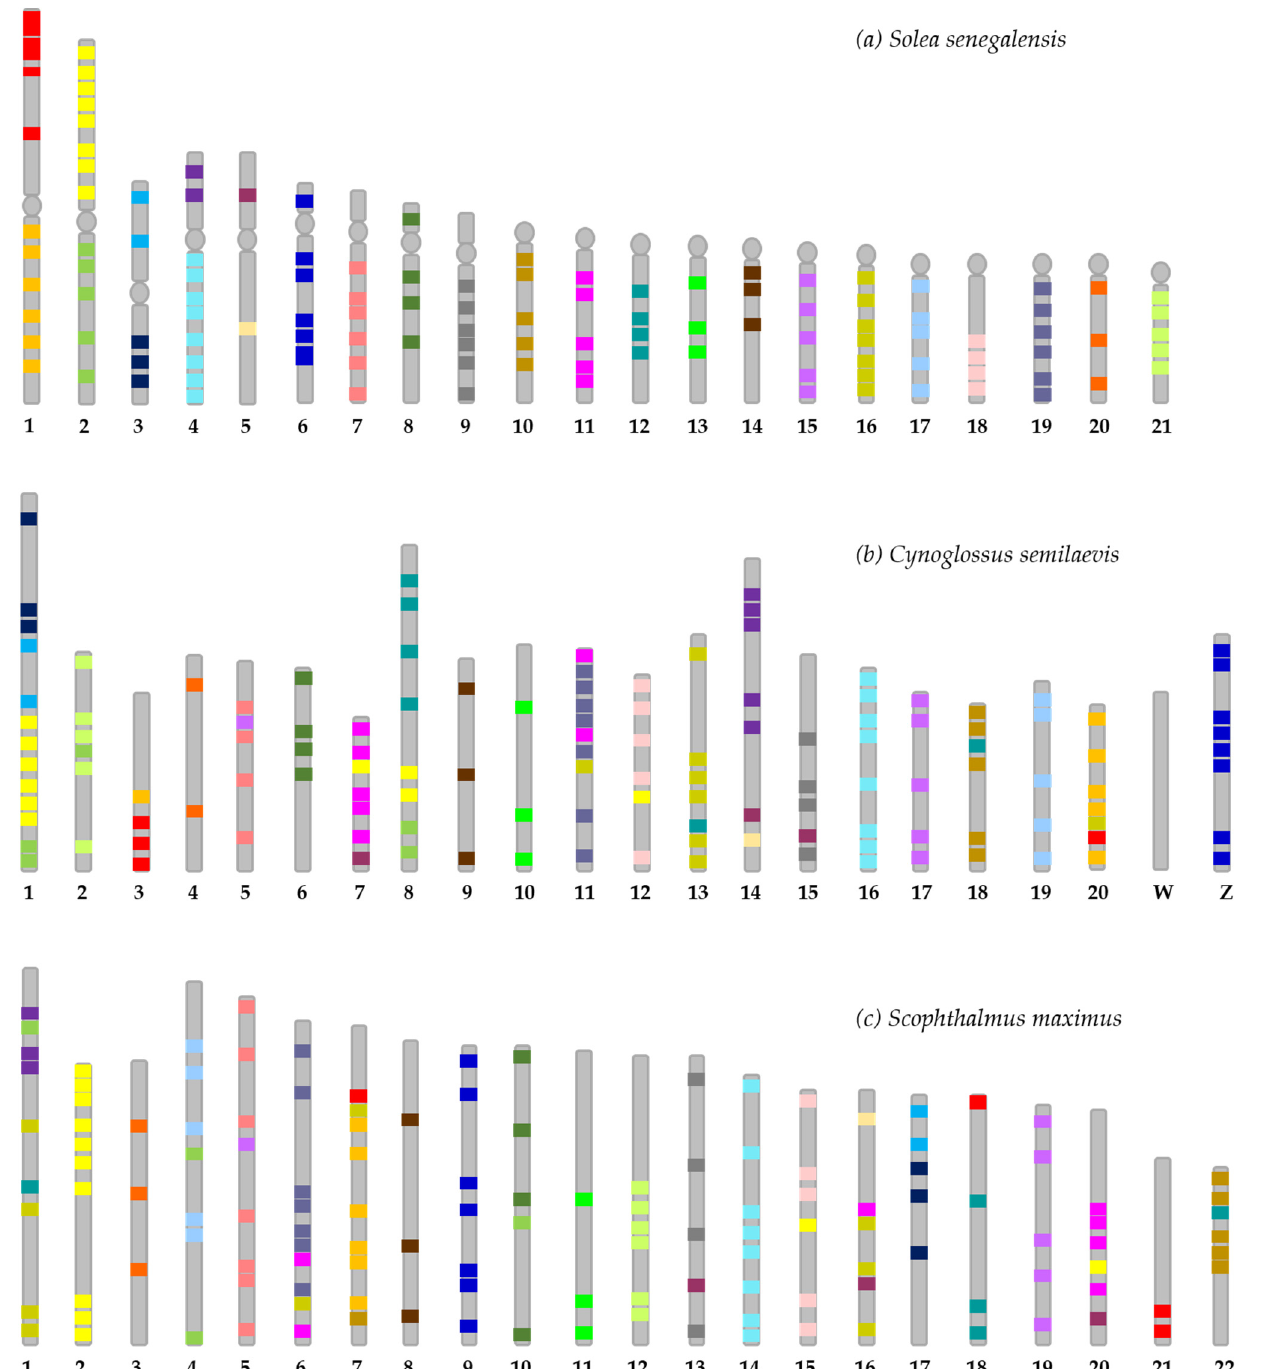
Figure 2. Comparative mapping of BAC clones localized in ( a ) Solea senegalensis with ( b ) Cynoglossus semilaevis , and ( c ) Scophthalmus maximus . BAC clones located in the same chromosome arm (consid ‐ ering metacentric and submetacentric chromosomes as bi ‐ armed) of S. senegalensis are represented with the same color.